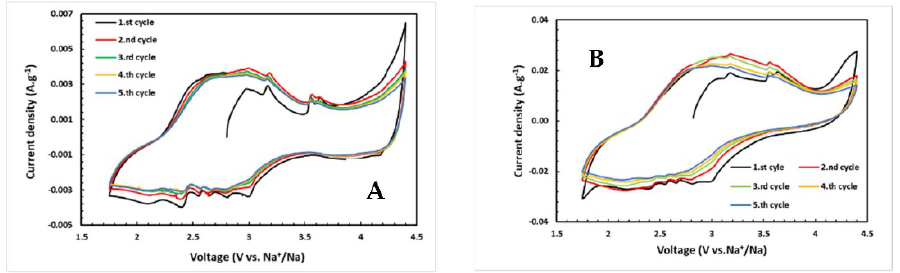
Figure 8. CV curves of ( A ) Fe02 and ( B ) Fe02-Q samples.